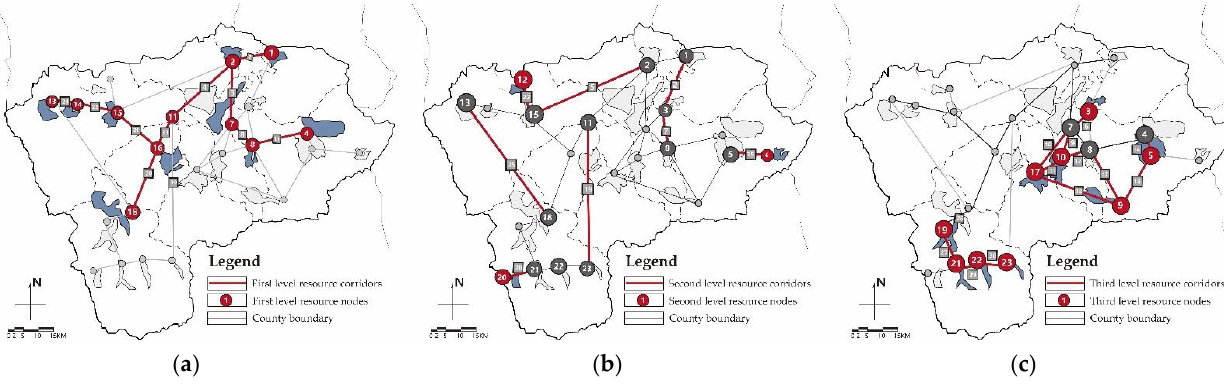
Figure 10. Classification of the abstract network:( a ) first, ( b ) second, and ( c ) third levels.